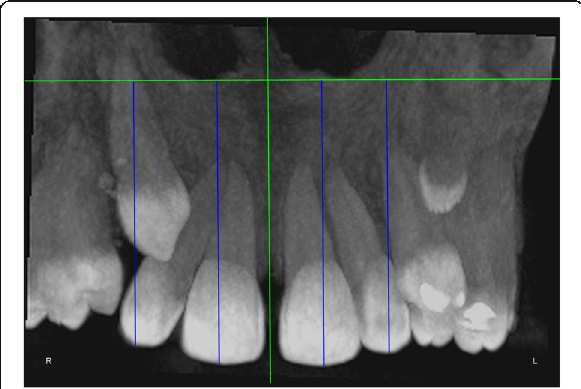
Fig. 2 Anterior dentoalveolar height. Measured in millimeters from the incisal edge of upper incisors by drawing a straight line parallel to the midsagittal plane till the floor of the nostrils on the side of the impacted canine and the side without impaction